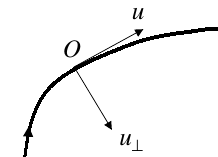
Figure 4. Coordinates u and u ⊥ attached to point O of a generic streamline shown as thick curve. Note that some actual streamlines are depicted in Figure